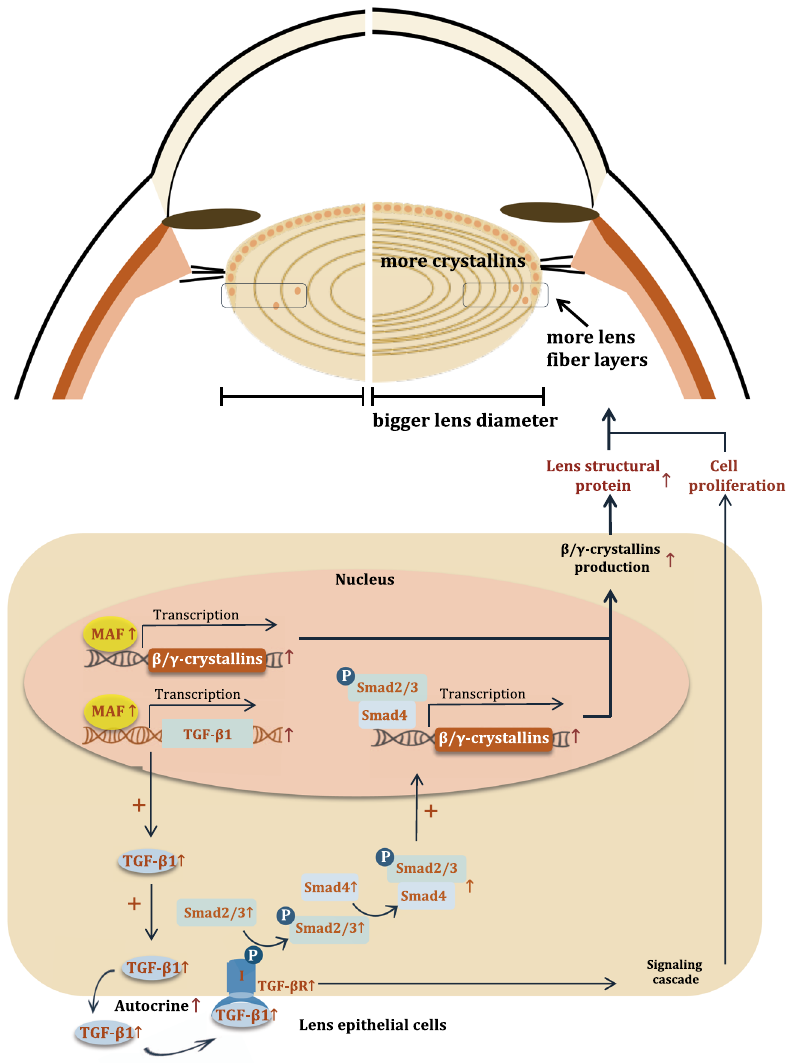
Fig. 10 Schematic illustration of the MAF-TGF- β 1-crystallin axis that underlies the pathological growth of lens in high myopia. Elevated MAF in lens of highly myopic eyes could promote β / γ -crystallin expressions by direct binding to their promoters and by boosting autocrine secretion of TGF- β 1 and subsequent Smad signaling pathway, together contributing to larger equatorial diameter of lens in highly myopic